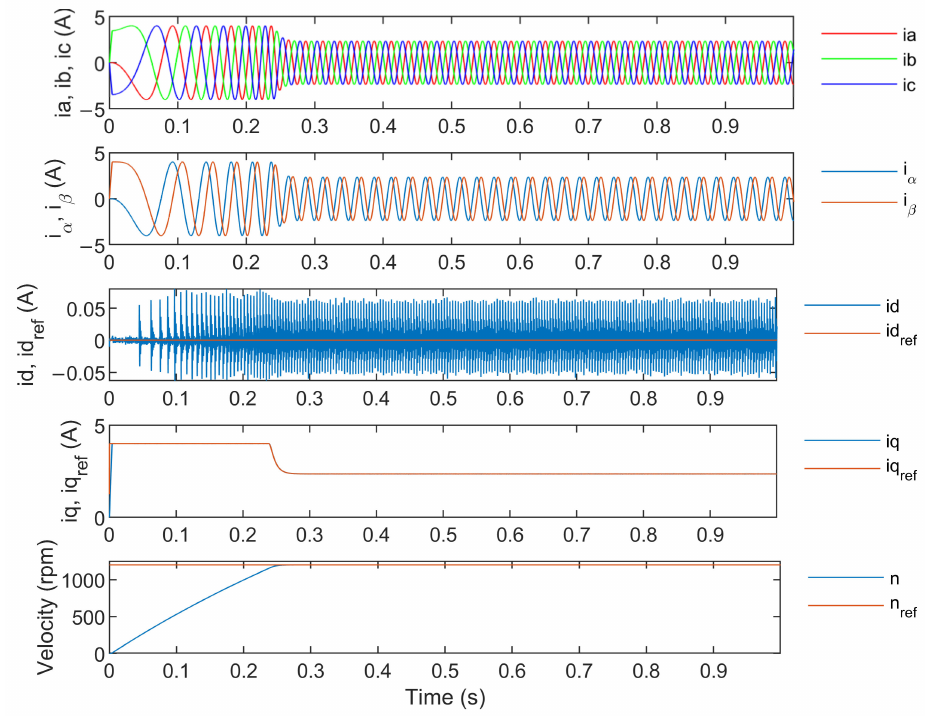
Figure 4. Simulation data collected for the healthy 6S3P topology.